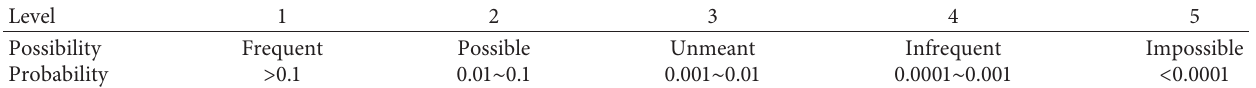
Table 2: Criteria for risk levels.